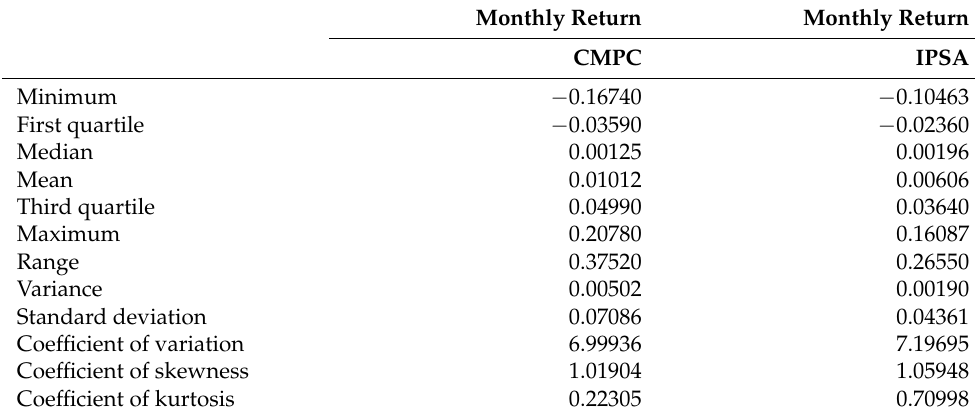
Table 2. Descriptive measures for CMPC and IPSA monthly returns